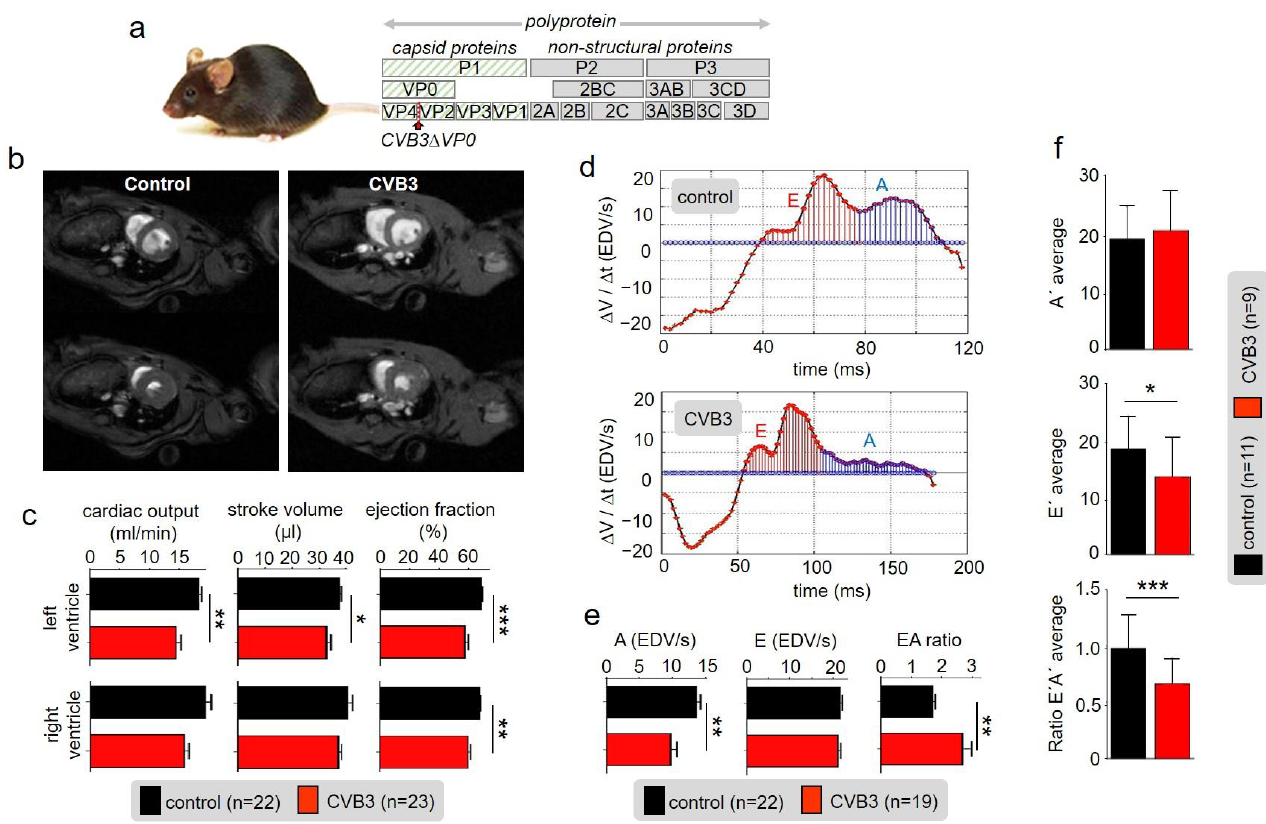
Figure 1. ( a ) Schematic illustration of the CVBΔVP0 expression system which was used to generate a transgenic mouse line. ( b ) Exemplary cardiac magnetic-resonance-imaging (CMR) of a wt mouse (left) and a CVB3ΔVP0 transgenic mouse (right). ( c ) Statistical analysis of measured cardiac output, ejection fraction and stroke volume (* indicates n < 0.05; ** indicates n < 0.01; *** indicates n < 0.001). ( d ) Volume–time filling curves of the left ventricle. ( e ) Statistical analysis of the early filling rate (E), atrial ejection (A) and EA ratio of CVB3 mice and control mice. ( f ) Analysis of tissue Doppler imaging (TDI) of transgenic CVB3 mice and control mice.